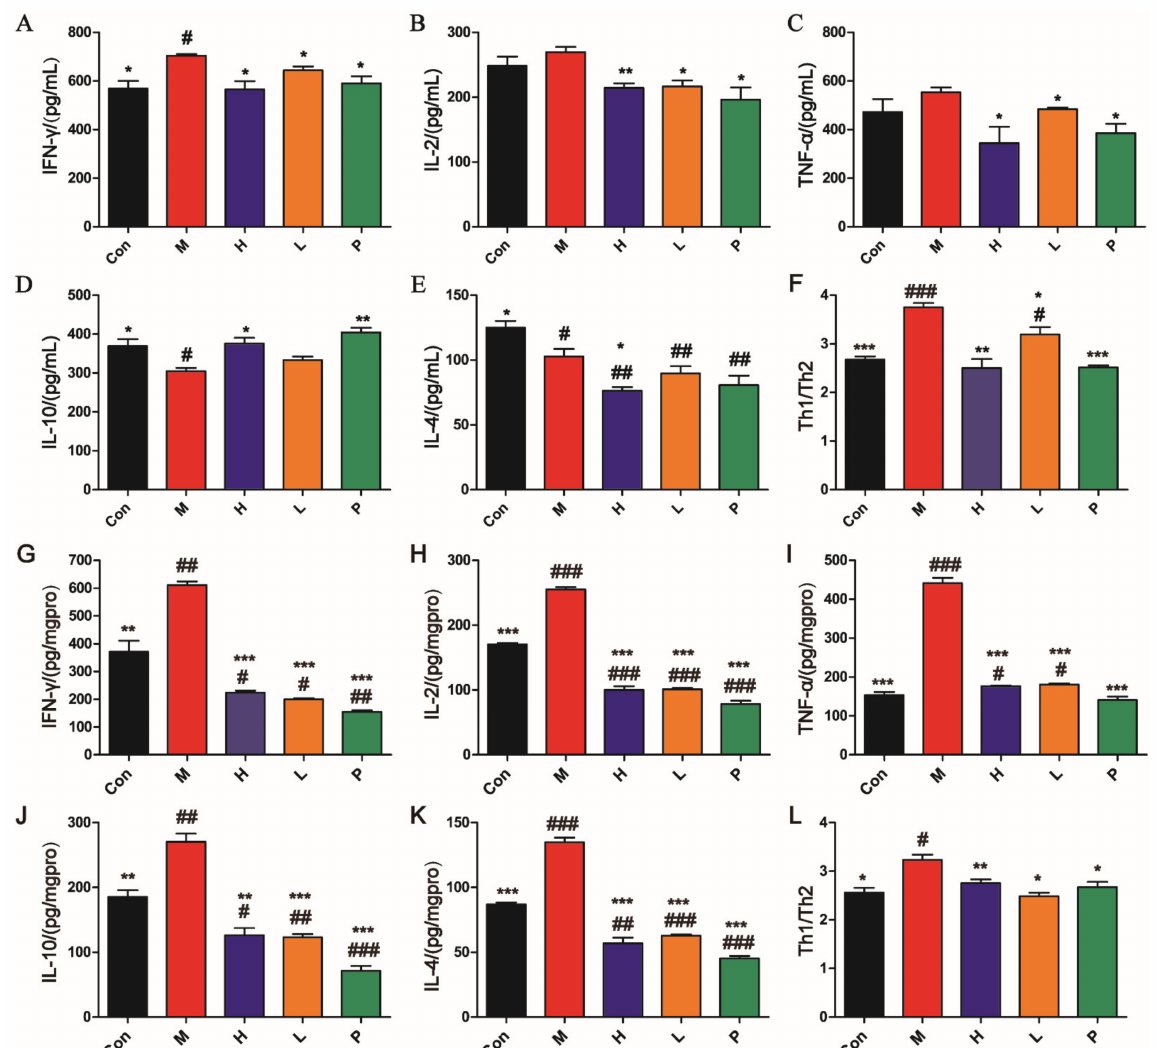
Figure 5. Effects of OPA on cytokines in serum ( A – F ) and colon tissues ( G – L ). Levels of IFN- γ ( A ), IL-2 ( B ), TNF- α ( C ), IL-10 ( D ), IL-4 ( E ), and Th1/Th2 ( F ) in serum and levels of IFN- γ ( G ), IL-2 ( H ), TNF- α ( I ), IL-10 ( J ), IL-4 ( K ), and Th1/Th2 ( L ) in colon tissues. Con was control group, M was model group, H was the high dose OPA group, L was low dose OPA group, P was positive group. Data were expressed as the mean ± SD ( n = 6), the statistical analyses were done with t -test; *** p < 0.001, ** p < 0.01, * p < 0.05 compared with the model group; ### p < 0.001, ## p < 0.01, # p < 0.05 compared with the control